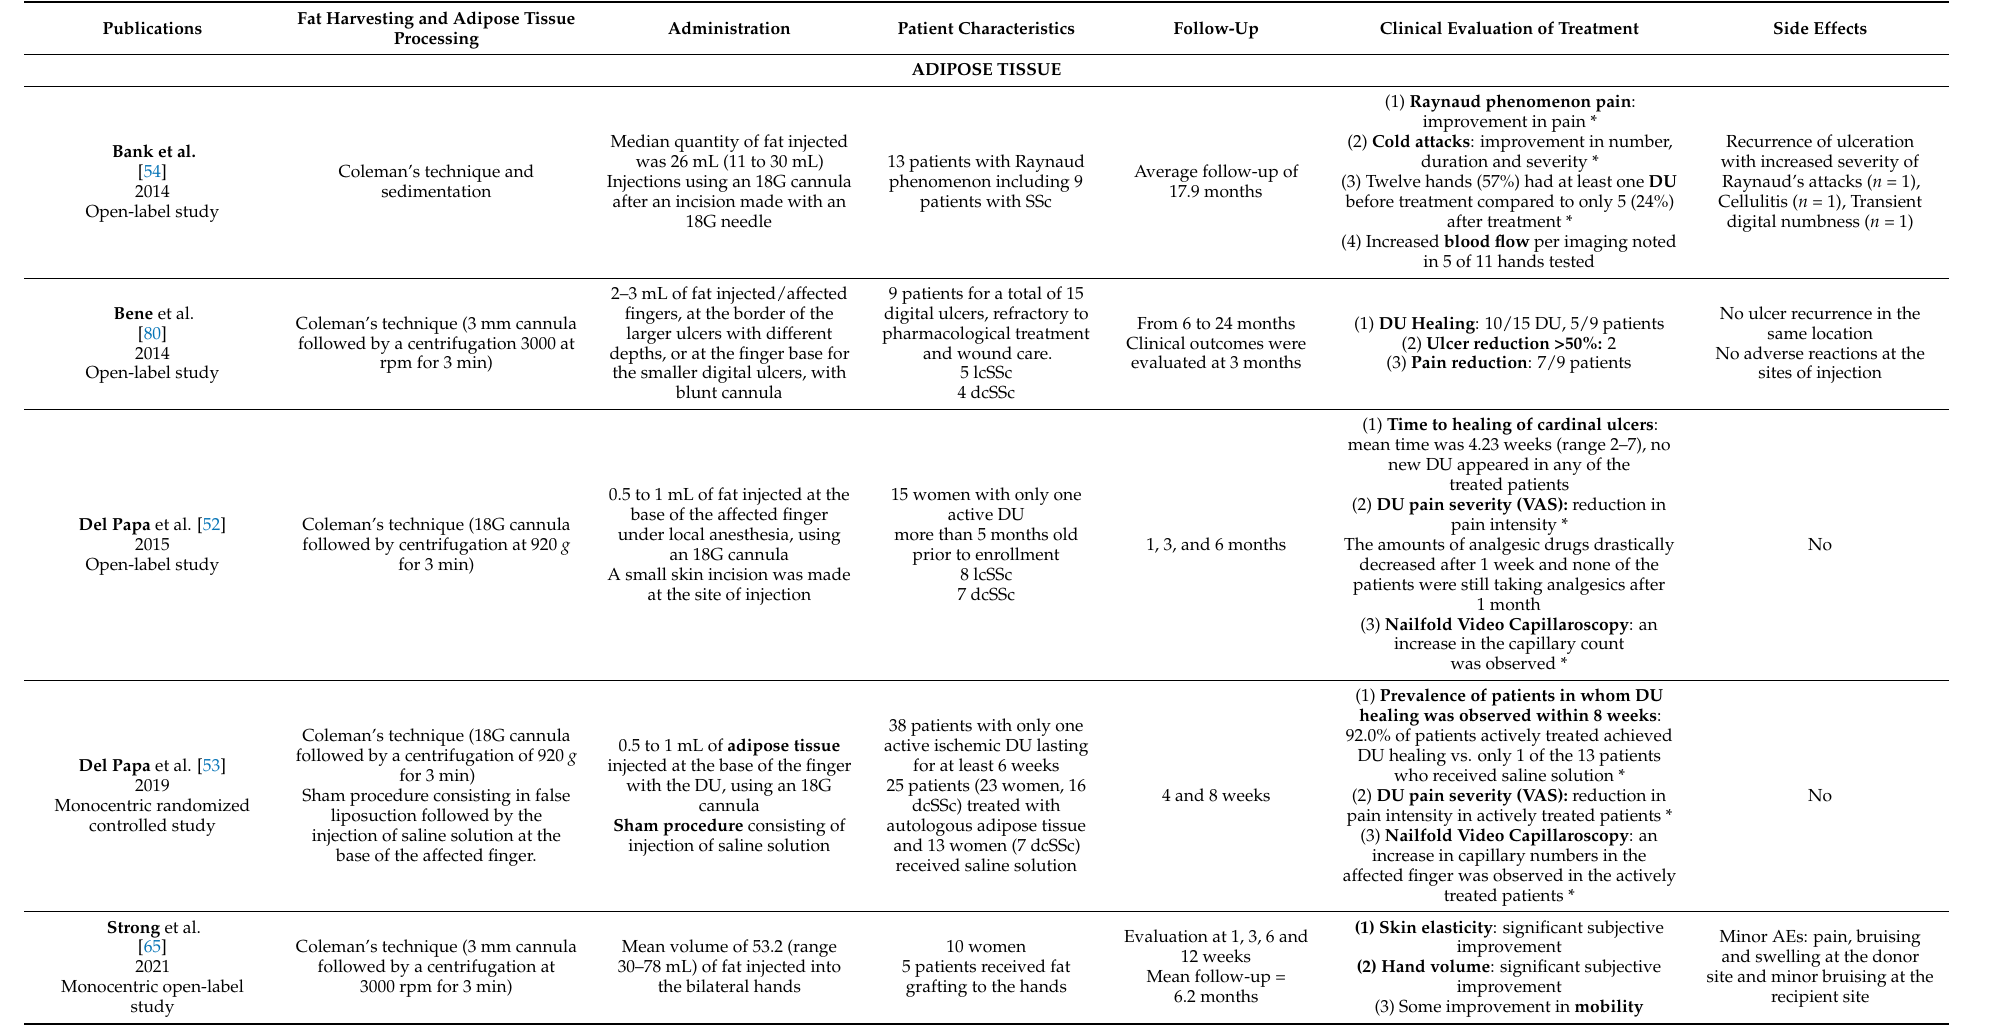
Table 2. Studies evaluating autologous fat-grafting and adipose-derived cell therapy products for the treatment of hand involvement in